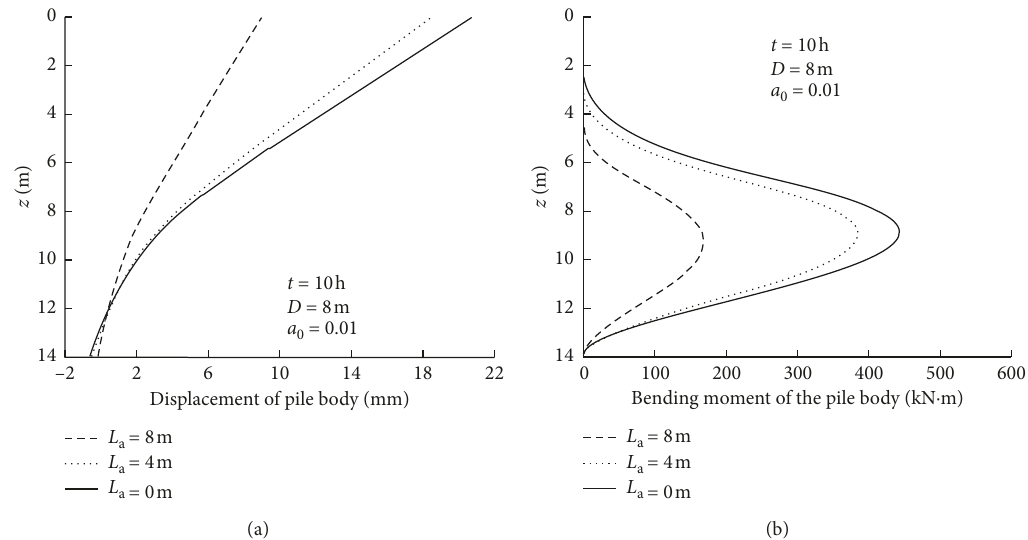
Figure 9: Effects of water table of active area on horizontal displacement and bending moment of pile. (a) Horizontal displacement of pile body. (b) Bending moment of pile